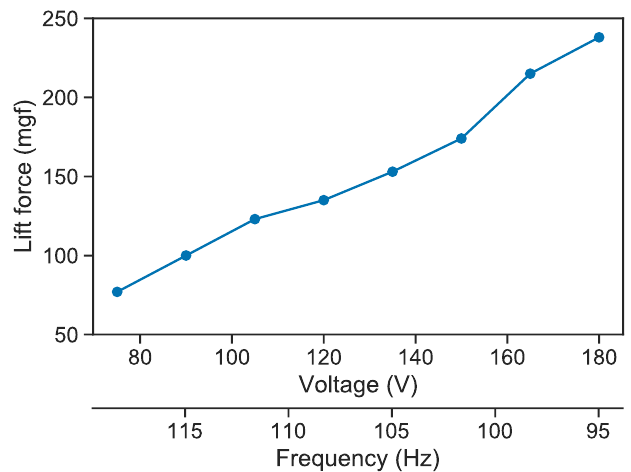
Figure 9. Lift force control based on simultaneous modulation of voltage and frequency.